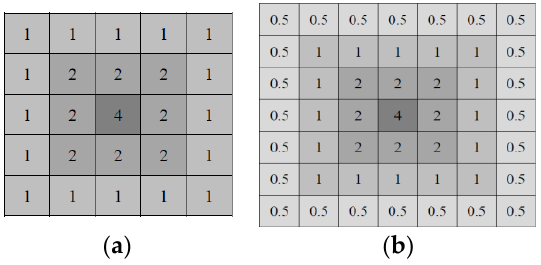
Figure 10. Gaussian weighting templates. ( a ) 5 × 5 and ( b ) 7 × 7.